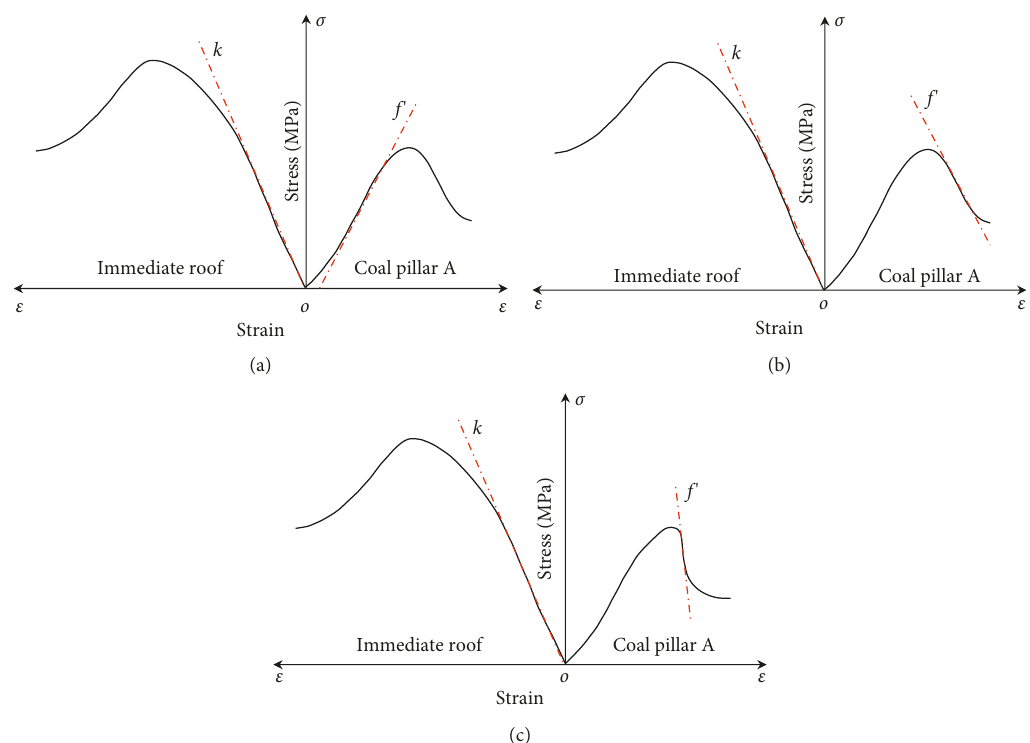
Figure 4: The strain-stress curves of coal-rock mass system when the acceleration of immediate roof movement is zero. (a) The coal pillar A is in an elastic state, (b) the coal pillar A is in a residual strength state (I), and (c) the coal pillar A is in a residual strength state